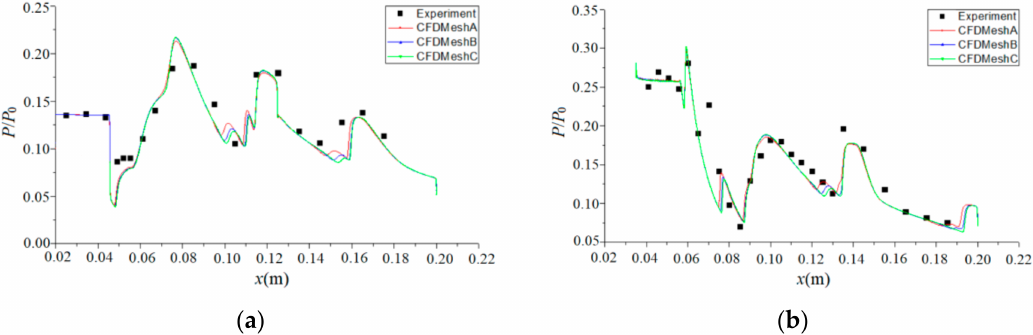
Figure 5. Comparison of wall pressure distribution Ma 0 = 2.41. ( a ) Upper wall. ( b ) Lower wall.